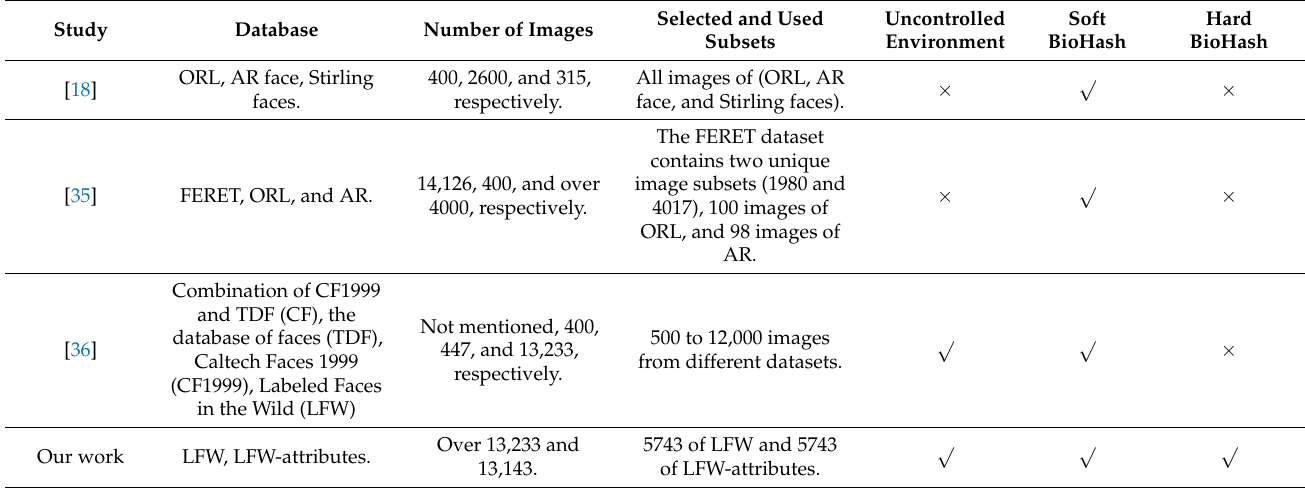
Table 3. Comparative analysis of the current study and previous